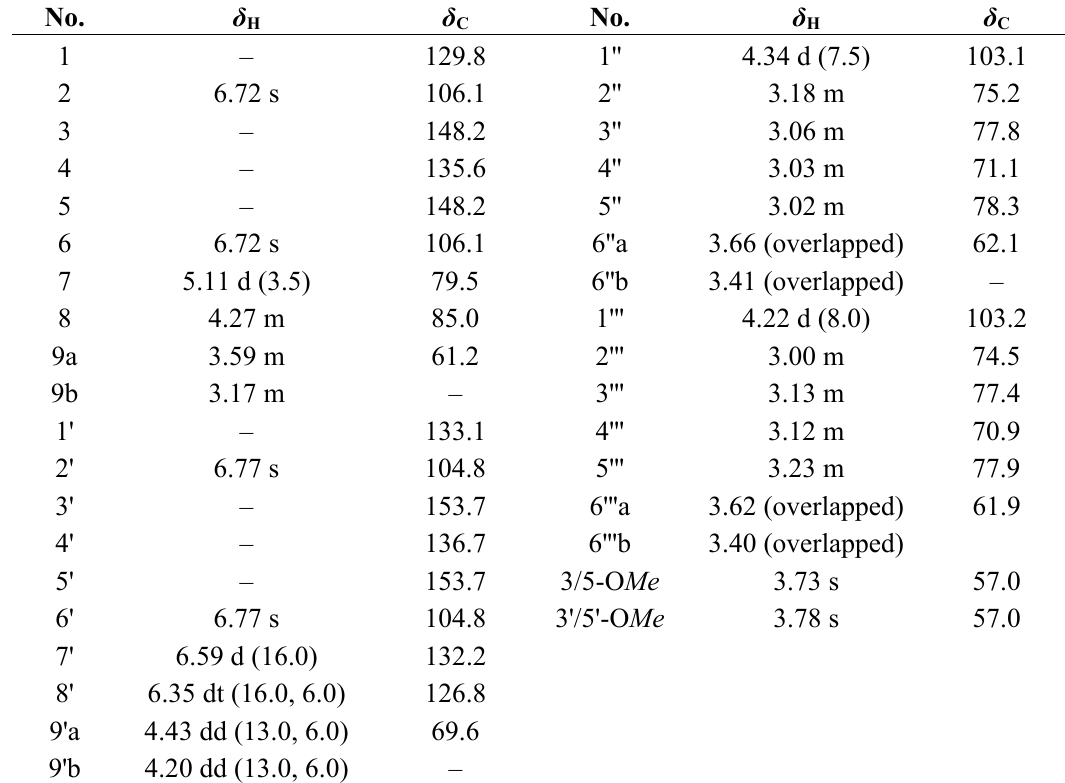
, δ in ppm, J in 6